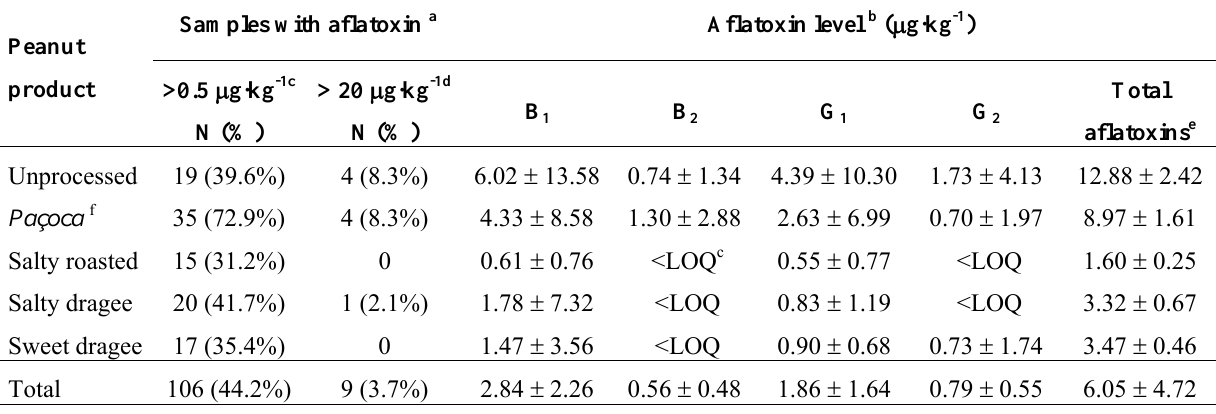
Table 1. Aflatoxin levels in peanut products traded in the Northeast region of the state of São Paulo,